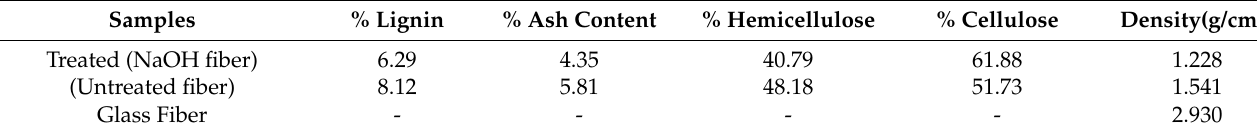
Table 2. The percentage constituents of Entada mannii natural fiber.